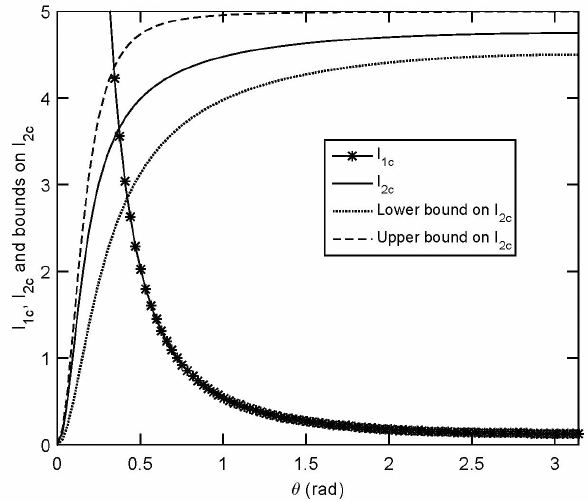
Figure 3. The integrands for the two influence coefficients for a control point on the vortex ring and θ 0 = 0. The stars show the inte- grand for I 1c from Eq. (2) with z = 0. The solid line shows I 2c . The dashed and dotted lines are the bounds on I 2c , Eq. (5) with s = 0 . 2. The sums were evaluated using Eq. (4) for 50000